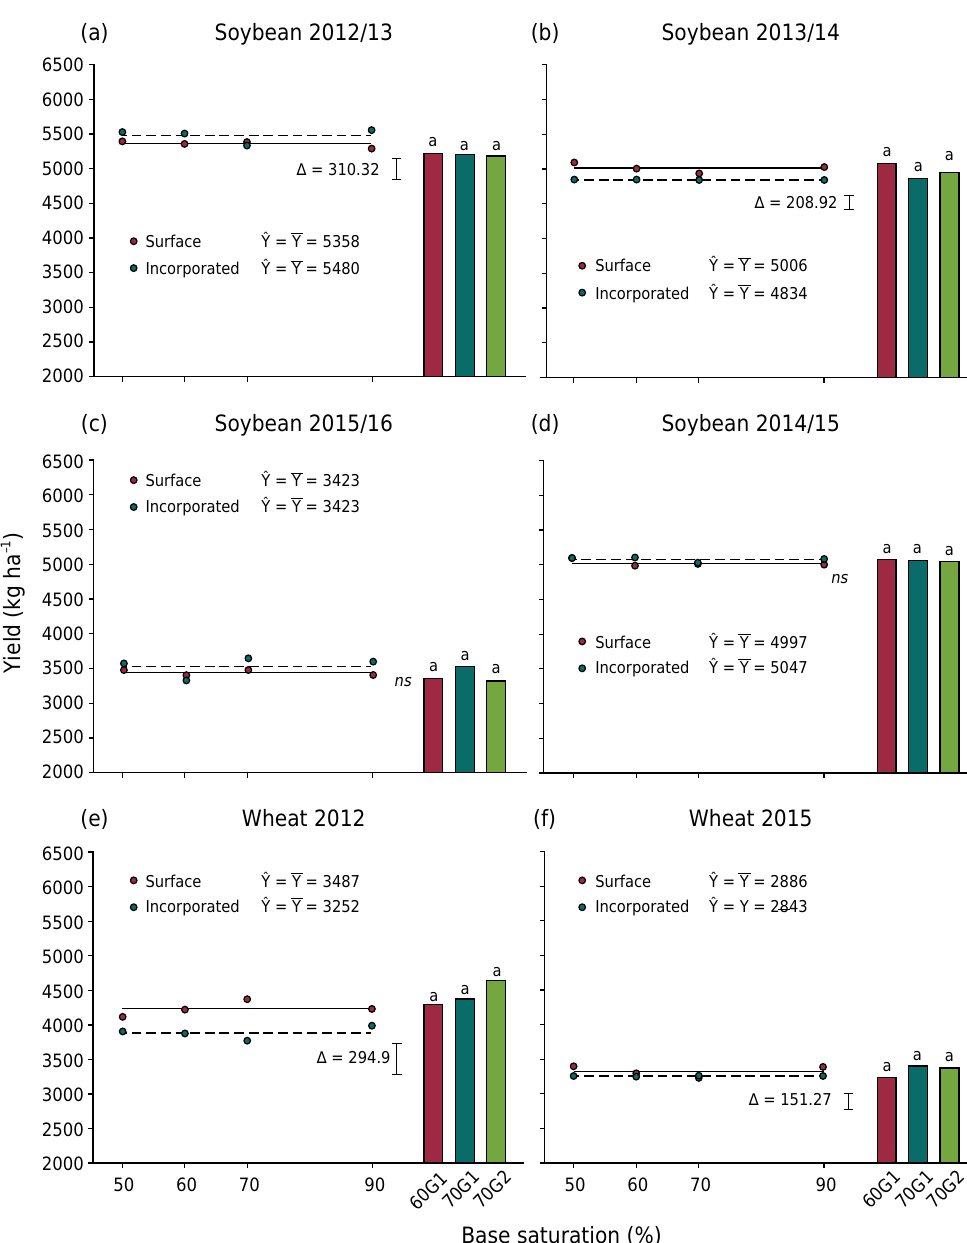
Figure 9. Yield of soybeans and wheat due to the application of lime and phosphogypsum. Soils were limed to different base saturation (BS) levels (50, 60, 70, and 90 %) by surface application (SL) or lime incorporation (IL) or treated by surface application of lime (60 and 70 % BS) and a standard (G1) or double (G2) dose of phosphogypsum as 60G1, 70G1 and 70G2. Different letters above columns indicate significant differences between phosphogypsum treatments (Tukey’s test, p<0.05). Vertical bars represent the least significant differences between treatments (Dunnett’s test, p<0.05), and “ns”means that there was no difference in the comparison between additional treatments and